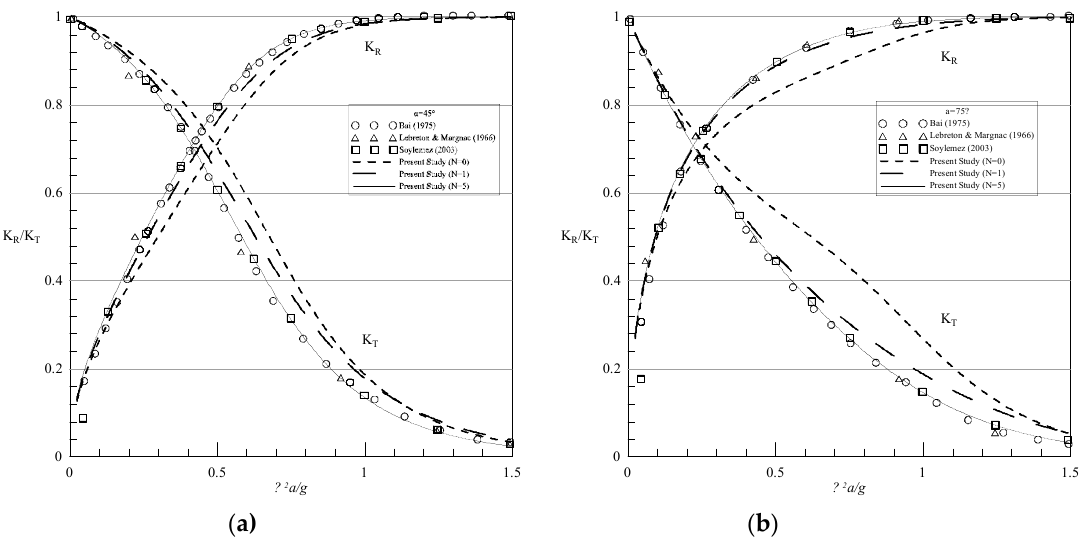
Figure 3. Schematic representation of the water wave scattering by a rectangular surface-piercing structure over flat bottom.